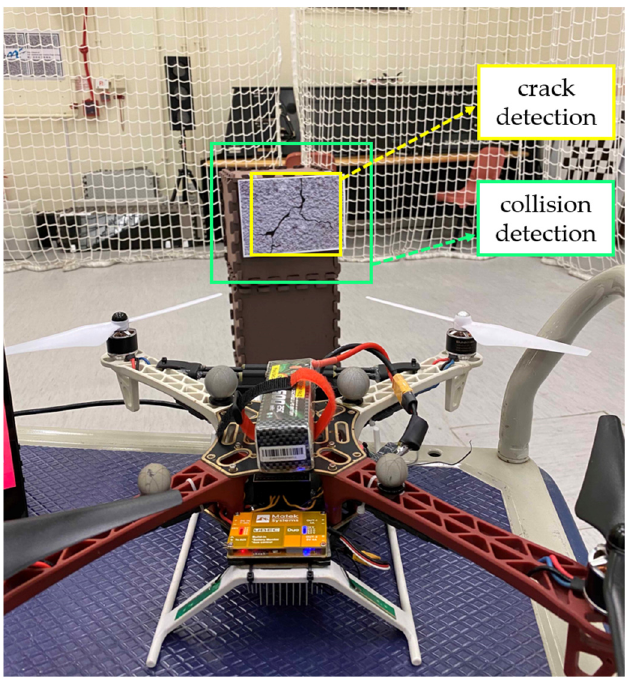
Figure 7. Collision detection using depth information from the surrounding environment.